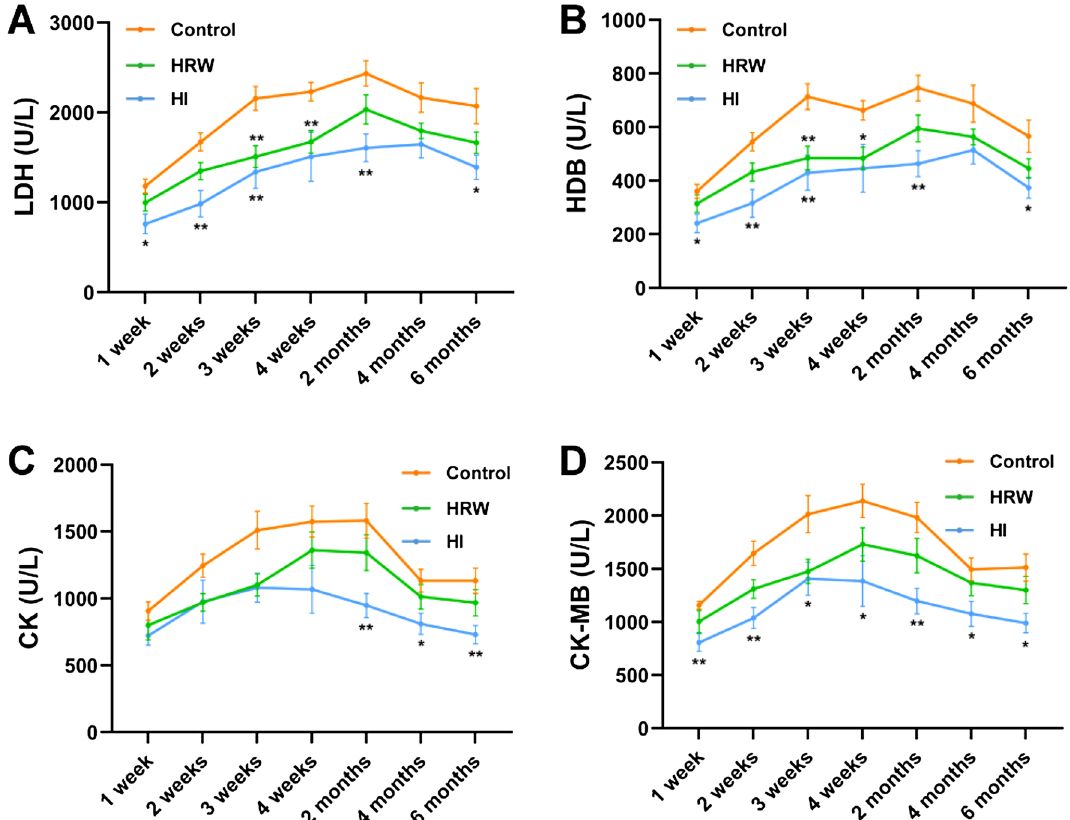
Figure 6. Effects of hydrogen treatment on serum myocardial enzymes spectrum. The activities of serum LDH (A) , HDB (B) , CK (C) and CK-MB (D) were monitored throughout the experimental period. Values shown are mean ± SEM (n = 10). For comparison of HRW or HI group and Control group, * p < 0.05, ** p < 0.01. Figure was made with GraphPad Prism 8.0.2, https ://www.graph pad.com/suppo rt/faq/prism -802-relea se-notes